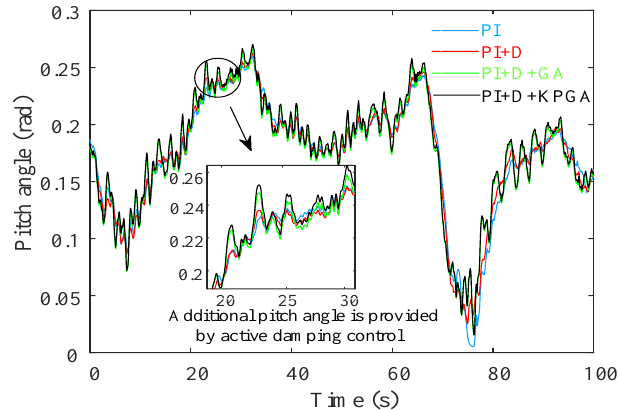
Figure 13. Change curve of the pitch angle. (1) The control performance.